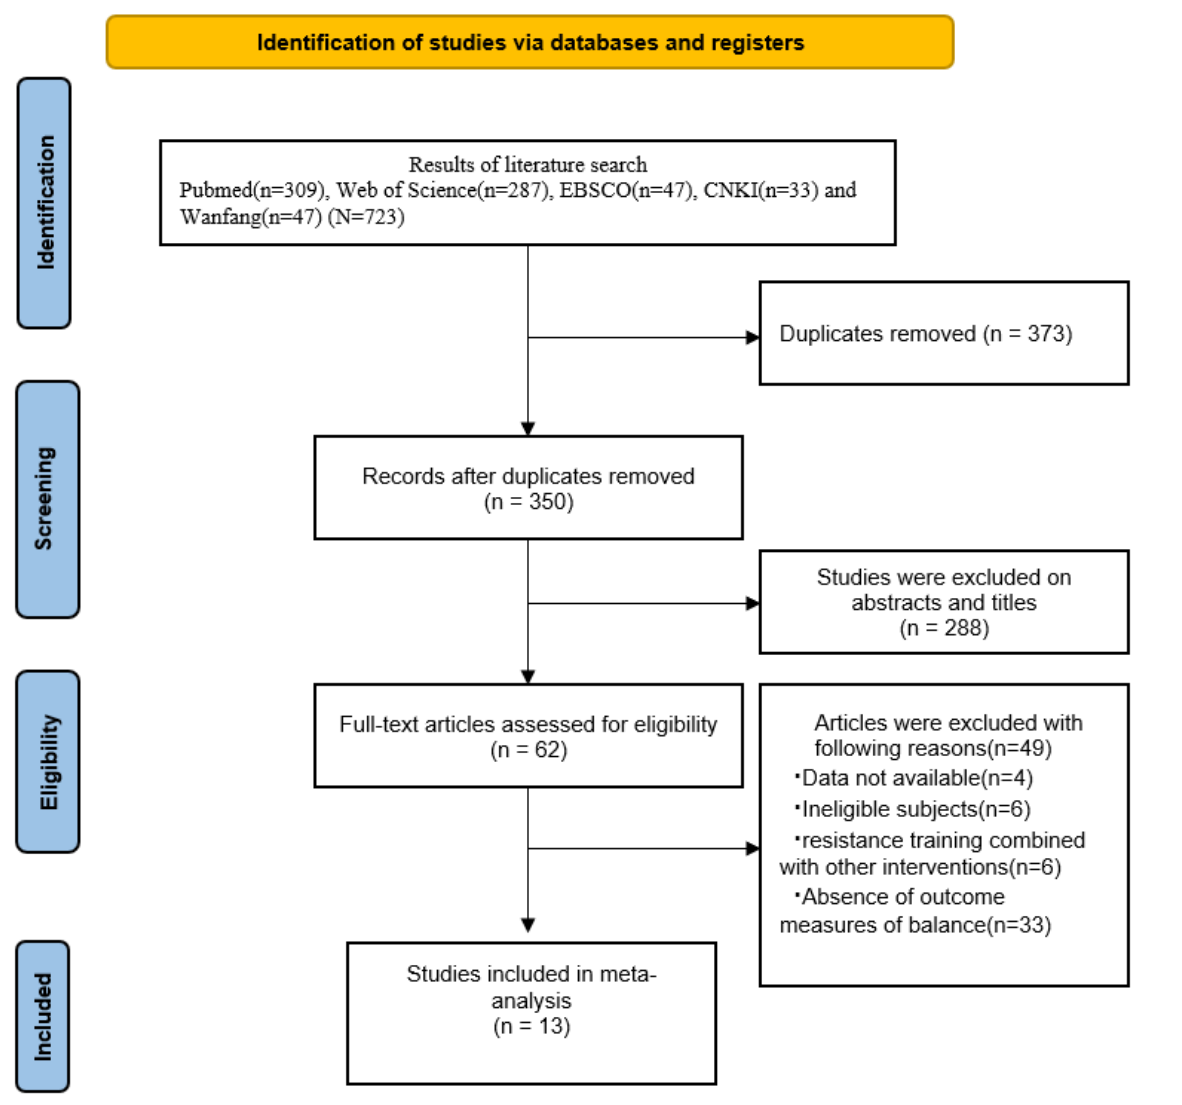
Figure 1. Literature selection process.